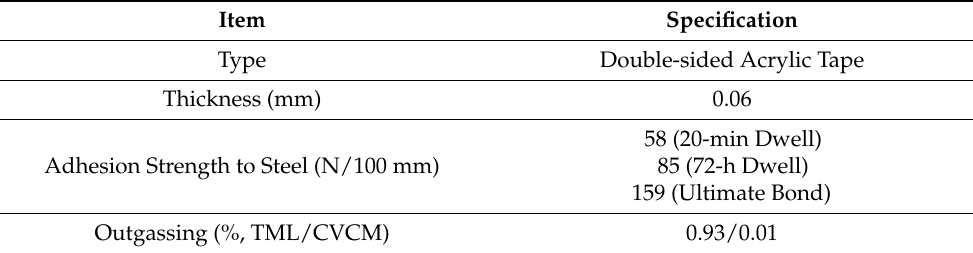
Table 2. Specifications of Viscoelastic Adhesive Tape